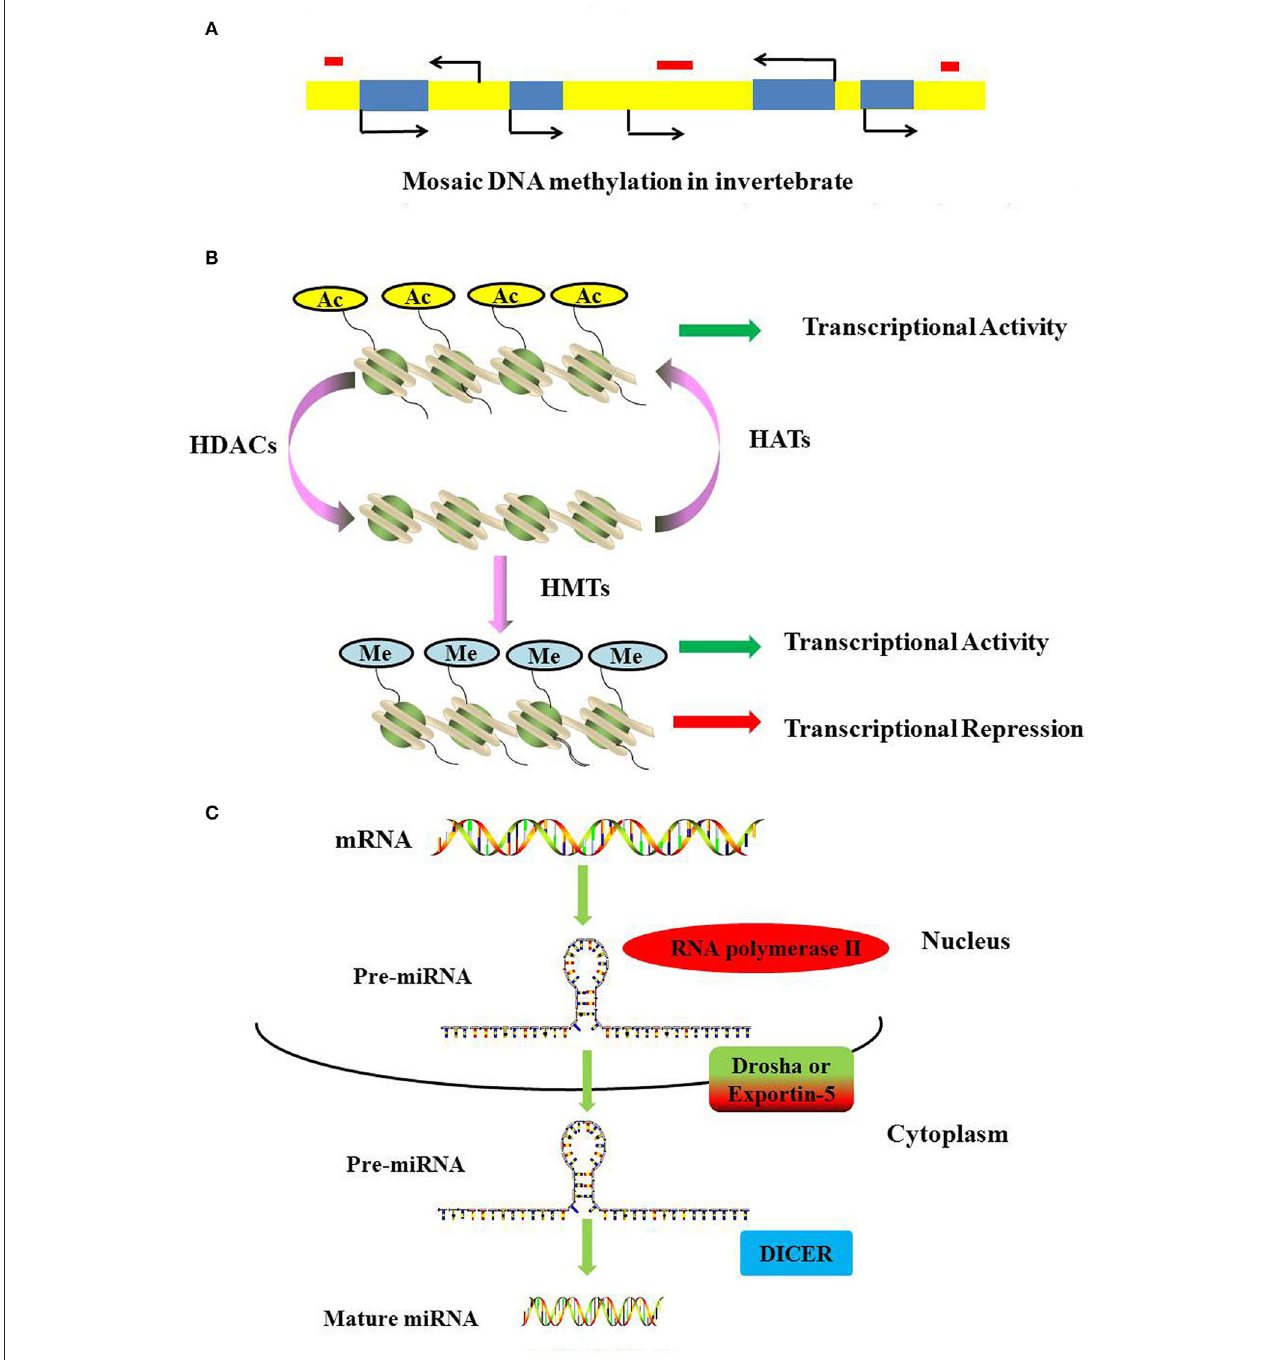
FIGURE 2 | Mechanisms of DNA methylation, histone modifications and miRNAs. (A) DNA methylation landscapes in invertebrates . Mosaic methylation is characteristic of most invertebrates. Mosaic methylation comprises domains of heavily methylated DNA interspersed with domains that are free of methylation. Mosaic DNA methylation consists of stable methylated (yellow) and unmethylated (blue) domains. The stable methylated and unmethylated domains are interspersed. Transposable elements are frequently unmethylated and match the methylation status of the surrounding DNA (red box). (B) Methylation and acetylation of histones. Histone acetylation can neutralize the positive charge of lysine, leading to a more relaxed structure of chromatin. The transcriptional machinery recruitment is permitted, and consequently transcription is activated. Histone methylation has been shown to be present during both transcriptional activation and repression. (C) The generation of miRNAs. The microRNAs are generated from long, capped, hairpin and polyadenylated pre-miRNAs, which are usually transcribed by RNA polymerase II (Pol II). Pre-miRNAs are processed by Drosha or Exportin-5, and then they are transported into the cytoplasm to be processed by RNase Dicer into mature double-stranded